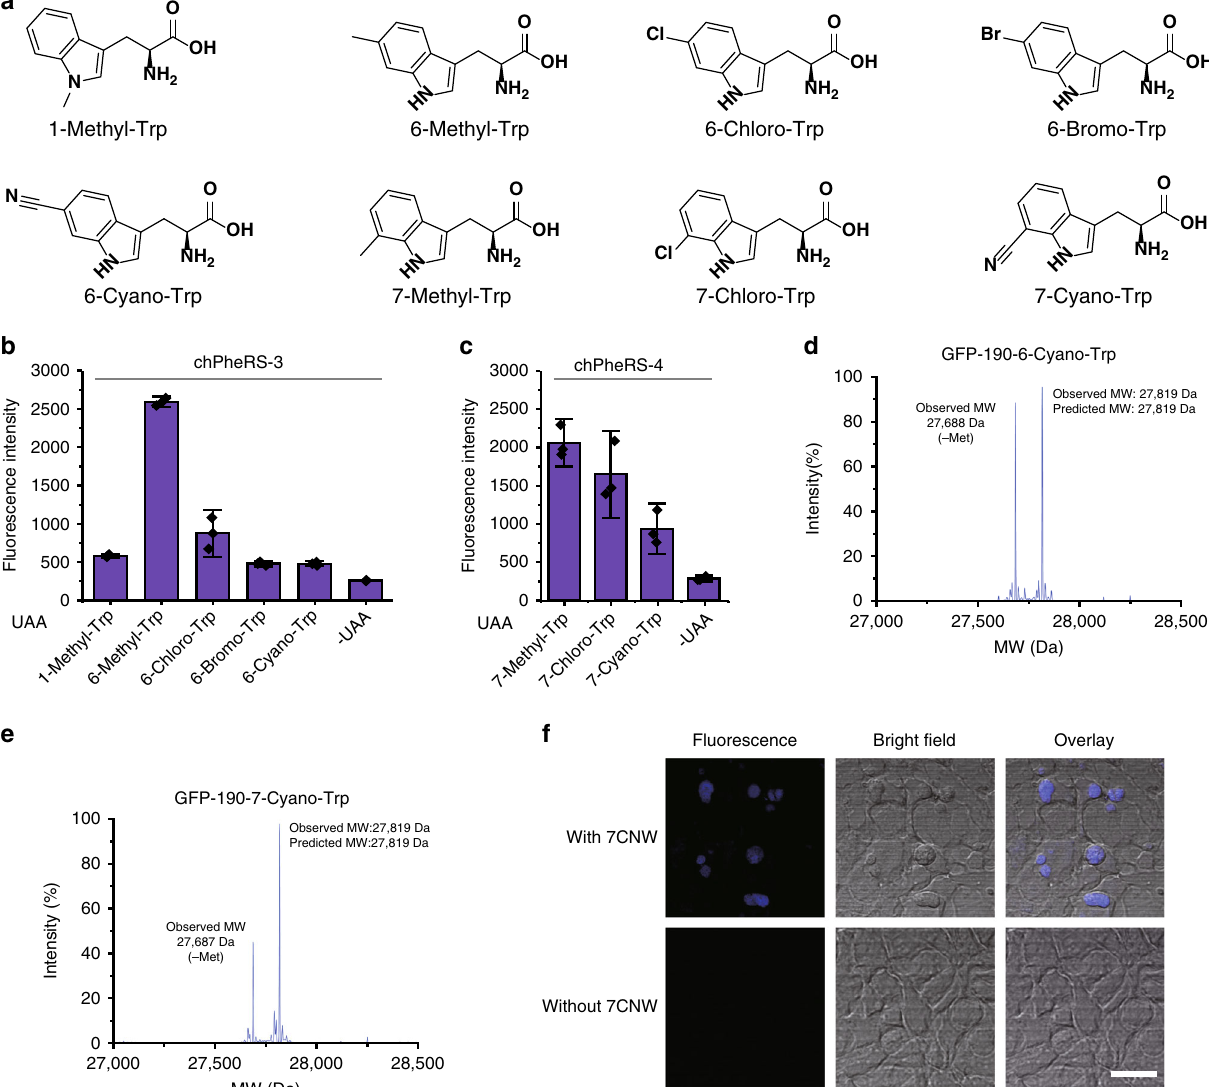
Fig. 6 Incorporation of Trp analogues with the chimeric PheRS/tRNA pair. a Chemical structures of the Trp analogues used in this study. Analysis of amber suppression activity of indicated Trp analogues (2 mM) by chPheRS-3 ( b ) and chPheRS-4 ( c ) using GFP reporter assay in E. coli . The synthetic details of amino acids 6CNW and 7CNW are described in Supplementary Fig. 23. The chPheRS-3 is a 6CNW recognition synthetase, and the chPheRS-4 is a 7CNW recognition synthetase. Mass spectrometry characterisation of 6CNW ( d ) or 7CNW ( e ) incorporation in GFP. f HEK293T cells are co-transfected with two plasmids: one carrying chPheRS-4 gene and chPheT gene, the other bearing Histone H3-E106TAG gene with or without the addition of 2 mM of 7CNW. Transfected cells are then visualised by two-photon microscopy. Scale bar: 25 μ m. Error bars represented ±standard deviation of the mean ( n = 3). Source data are available in the Source Data fi